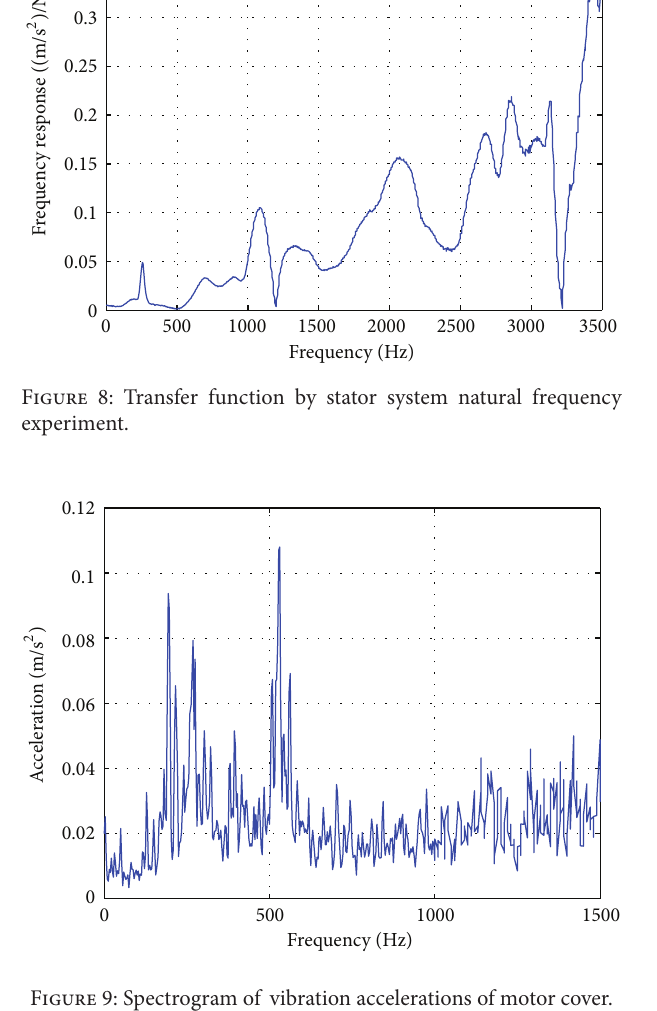
measured value of vibration acceleration of motor shield were listed in Table 5.